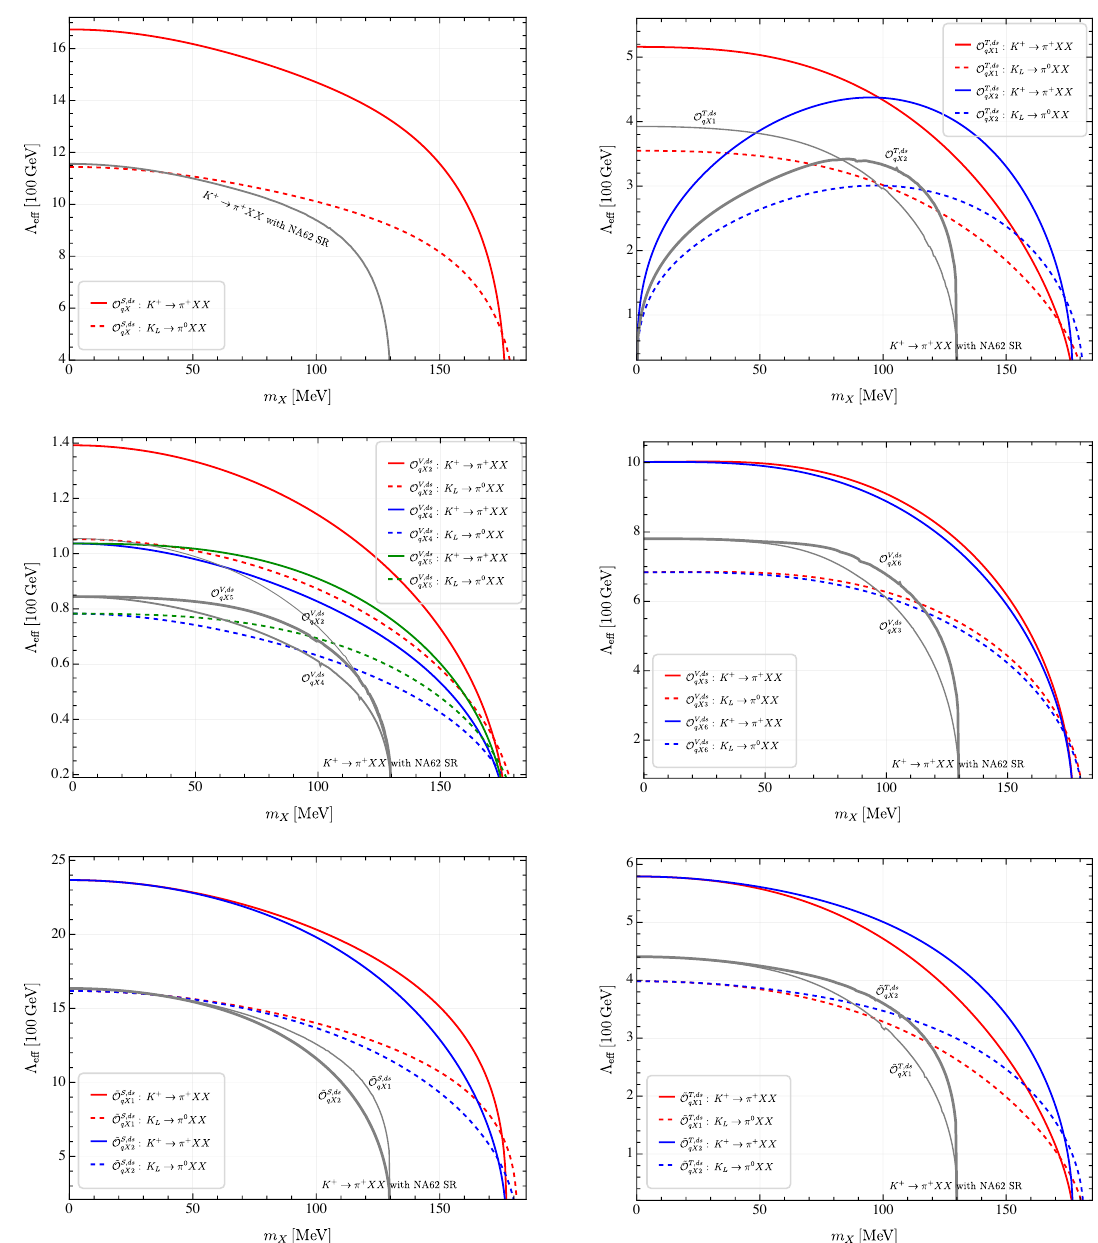
Figure 12 . Constraints on the effective new physics scale for the vector DM operators with d, s quarks as a function of the DM mass m from K → π /E